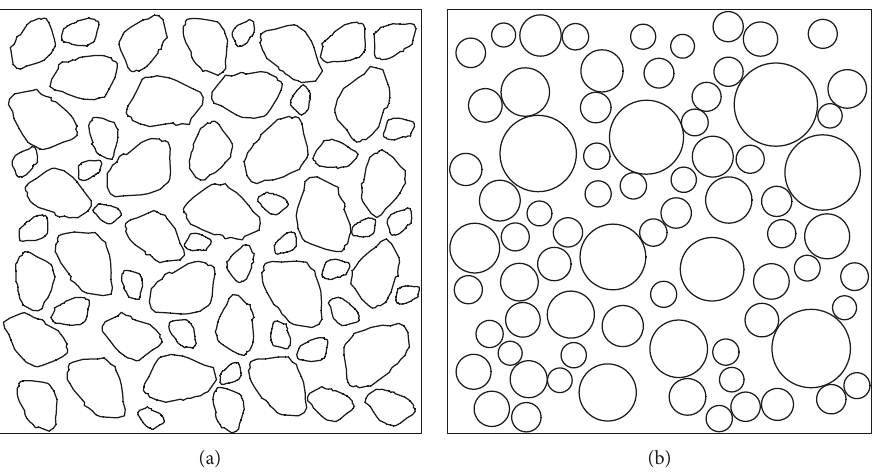
Figure 6: Specimen geometry model. (a) Actual random aggregate. (b) Circle random aggregate.